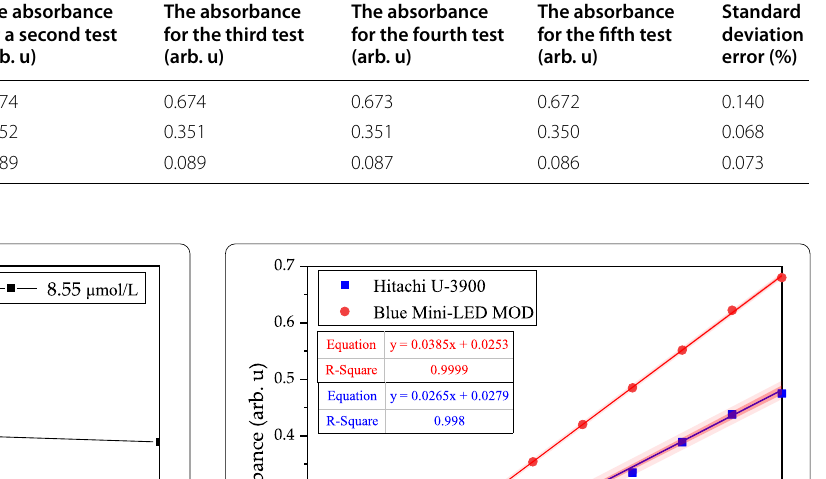
The absorbance for the first test (arb. u)